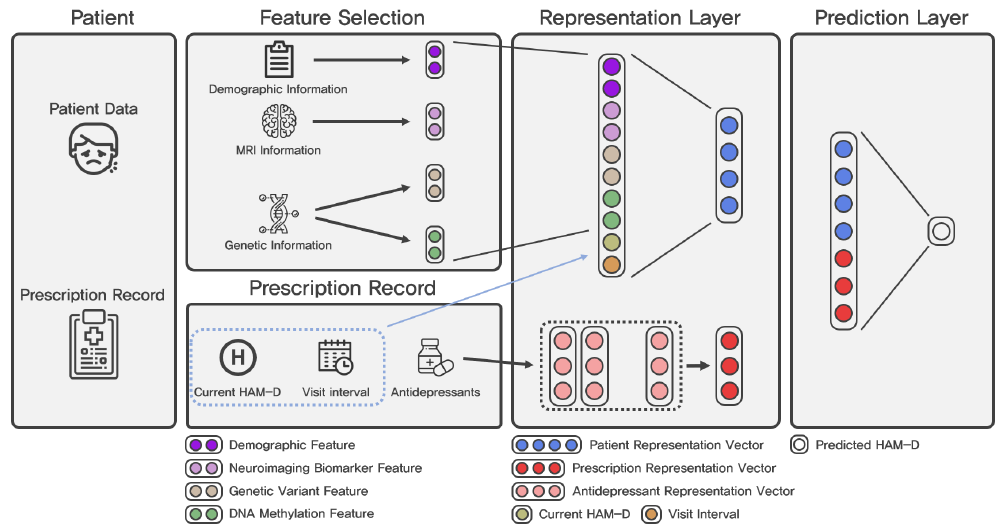
Figure 1. Architecture of our proposed ARPNet